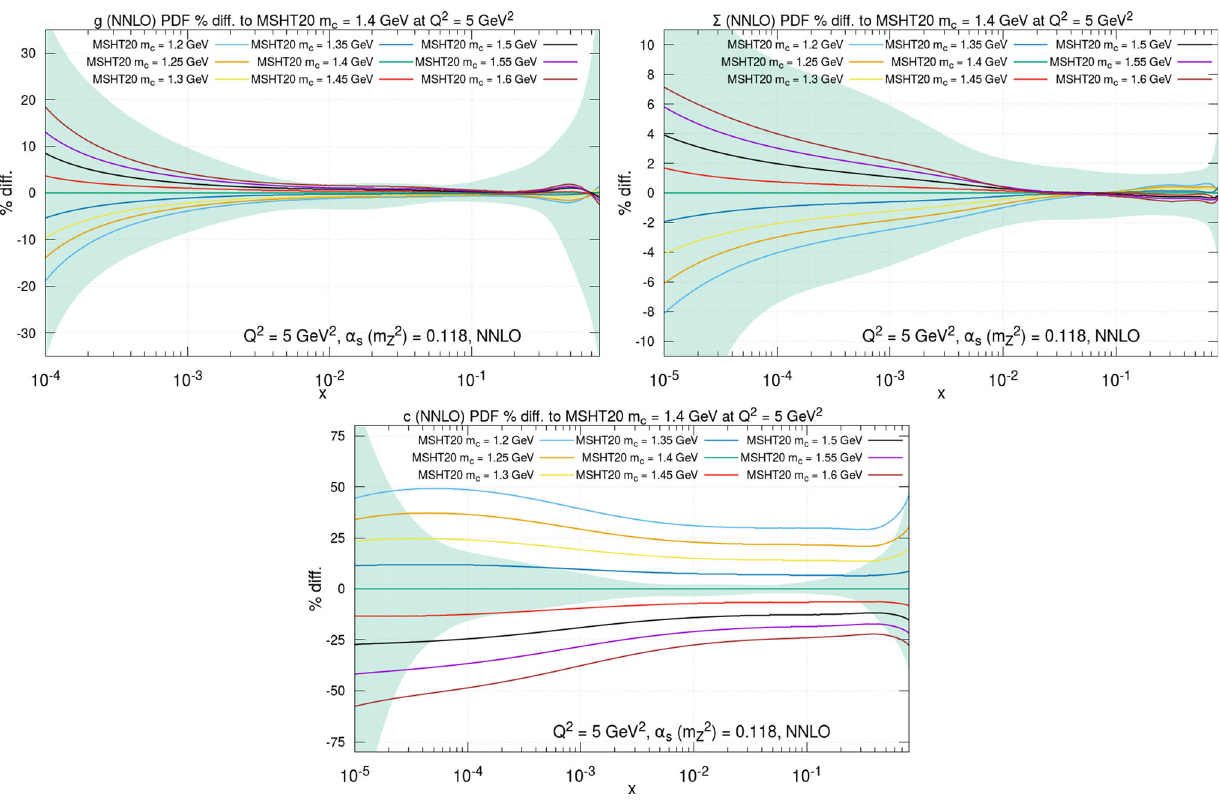
Fig. 23 The m c dependence of the gluon, light-quark singlet and charm distributions at NNLO for Q 2 = 5 GeV 2 , compared to the standard MSHT20 distributions with m c = 1 . 4 GeV and m b = 4 . 75